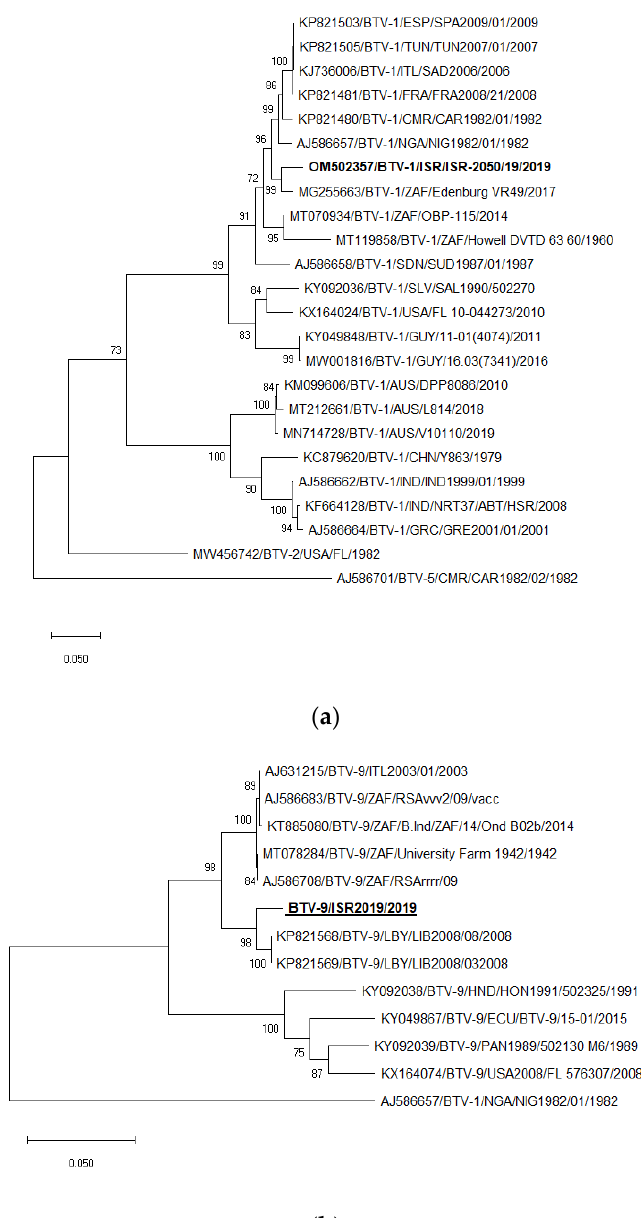
Figure 3. Phylogenetic tree of segment 6 of Israeli BTV-1 and BTV-9 strains isolated in 2019. ( a ) Phylogenetic tree of Israeli and global BTV-1 strains. BTV-5 was used as an outgroup. Israeli BTV-1 strain is shown in bold. ( b ) Phylogenetic tree of BTV-9 and global BTV-9 strains. BTV-1 was used as an outgroup. Israeli BTV-9 strain is shown in bold and underlined. The phylogeny was inferred using the Maximum Likelihood method and Tamura–Nei model method. The percentage of replicate trees in which the associated taxa clustered together in the bootstrap test (1000 replicates) are shown next to the branches. Viruses were identified by accession number/serotype/location/isolate/year.